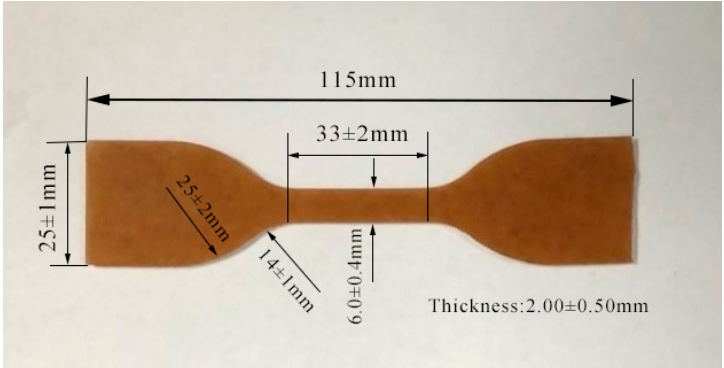
Figure 1. Dimension of the dumbbell ‐ shaped sample of the hydroxyl terminated polybutadiene (HTPB) coating.